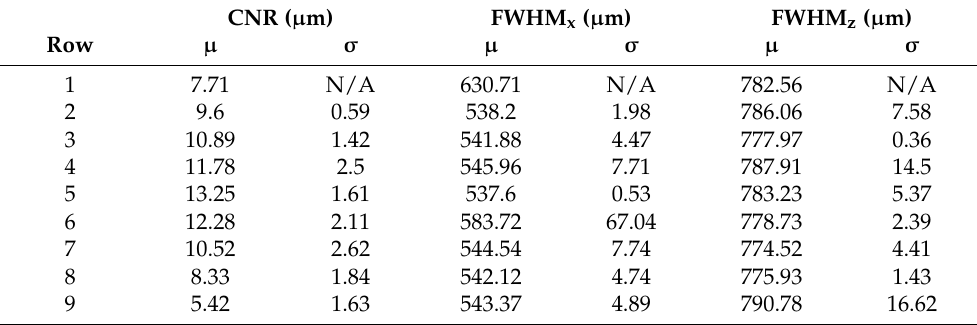
Table A4. Comparison of CNR and resolution for each row in the multi-point